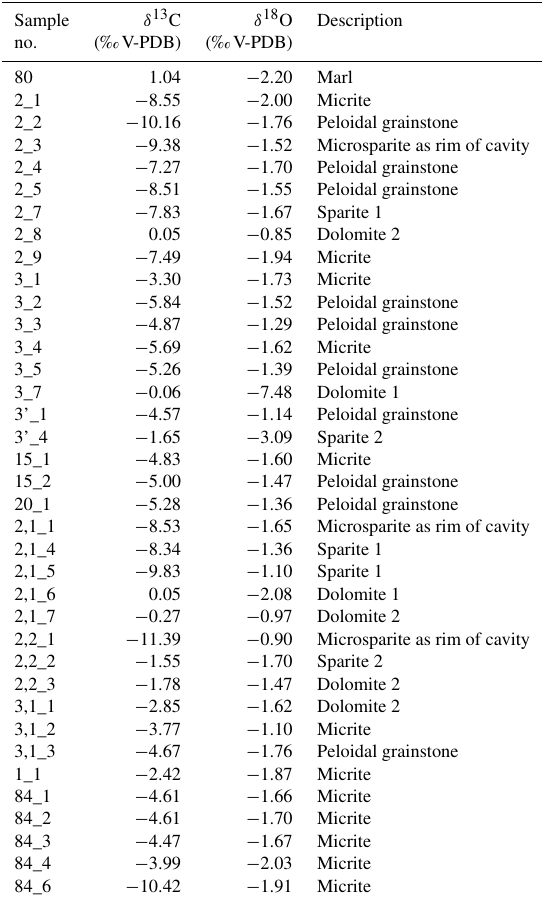
Table A1. Results of carbon and oxygen isotope analysis for the 37 studied examples in this